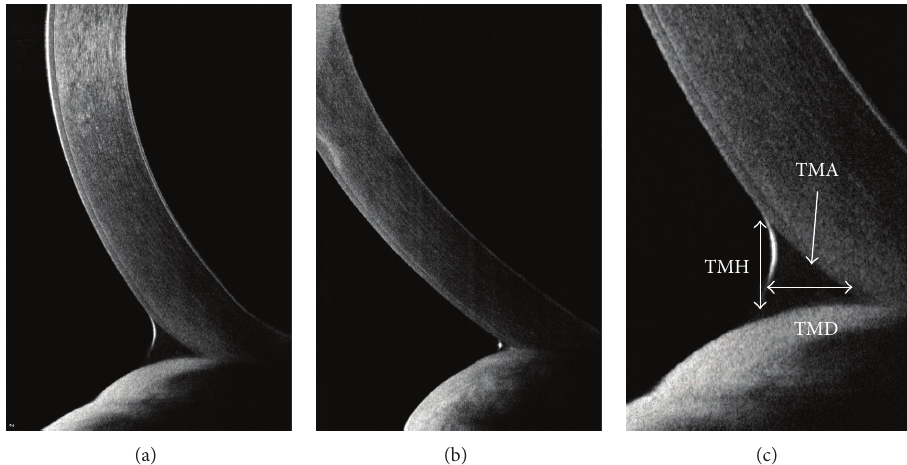
Figure 2: Tear meniscus measurement by AS-OCT. Normal (a), dry eye syndrome (b), three parameters that were usually measured (c); tear meniscus height (TMH), tear meniscus depth (TMD), and tear meniscus area (TMA).